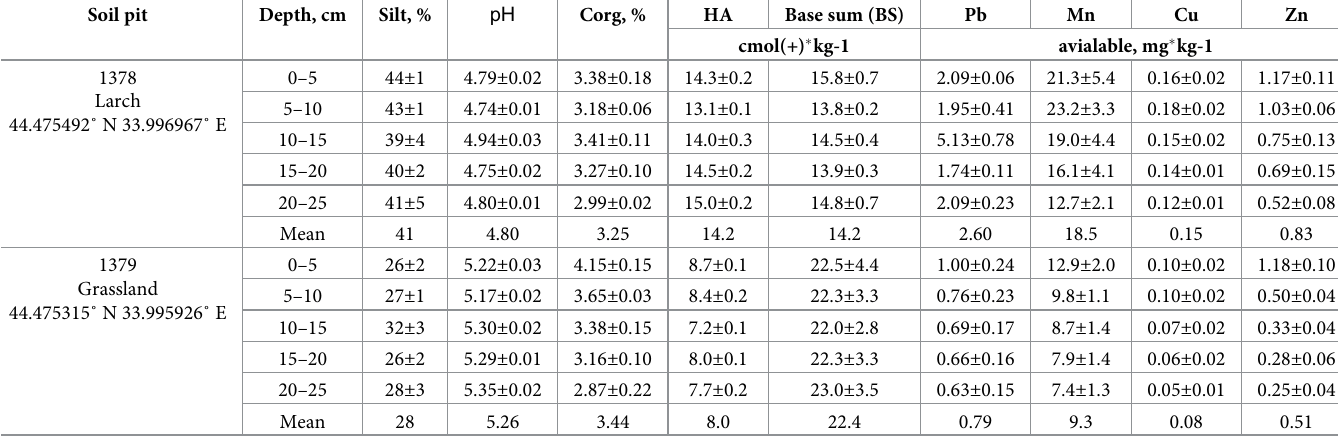
Table 1. Soil properties under artificial larch plantations and grassland vegetation. The values are presented as Mean ± SD. Soil